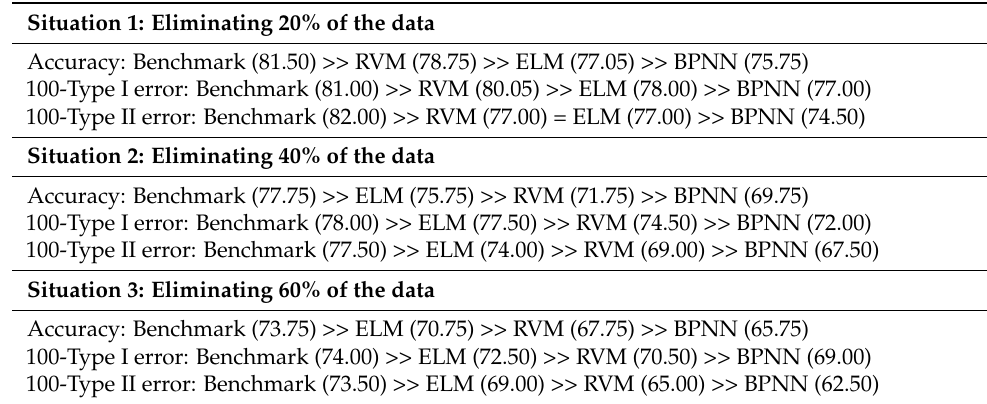
Table 10. The outcomes of comparison under four